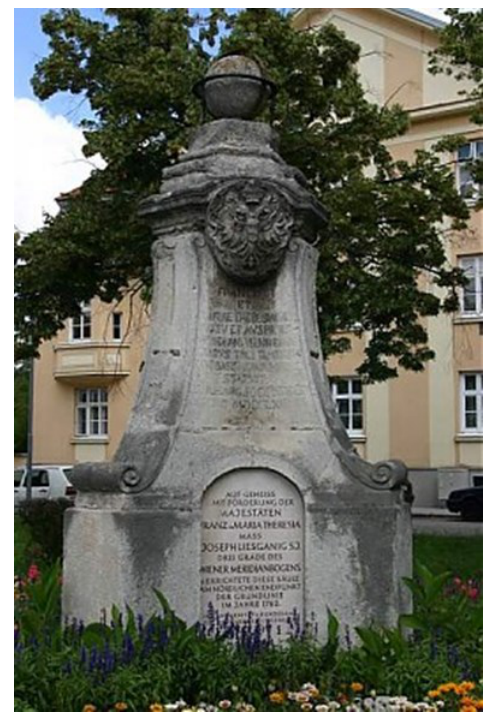
Figure 5. The Liesganig Monument in Wiener Neustadt, erected 1762, reminds on the earliest framework triangulation for topo- graphic and cadastral mapping of the Austrian-Hungarian Mon- archy. (Source: Monument Protection Association Wiener Neu- stadt, http://www.denkmalschutz-wn.at)